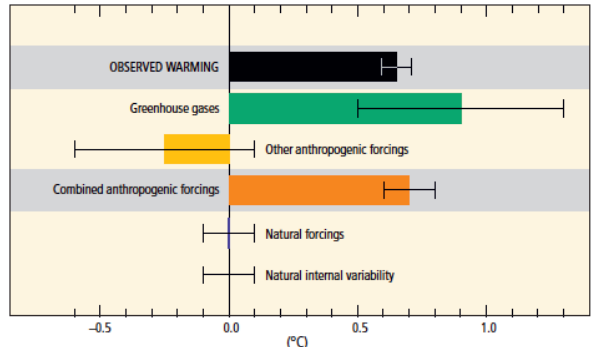
Figure 2. Comparison between the observed increase of global mean temperature (GMST) over the period 1951-2010 and the esti- mated anthropogenic contribution. The black bar is the observed GMST over the period, while the green and yellow bars repre- sent the modelled contribution of GHGs and other climate forcers (mainly atmospheric aerosols that exert a cooling effect on climate; Fuzzi et al., 2015), respectively. The orange bar is the sum of the two (green + yellow) representing the total modelled temperature increase due to anthropogenic emissions. As can easily be seen, the modelled and observed GMST increase are very close to each other, taking into account the uncertainty ranges of the different quanti- ties (the 5 to 95% uncertainty range is reported on top of each bar). The natural contributions to GMST increase and the internal vari- ability of the Earth’s climate system are minimal, if not negligible (from IPCC 2014).